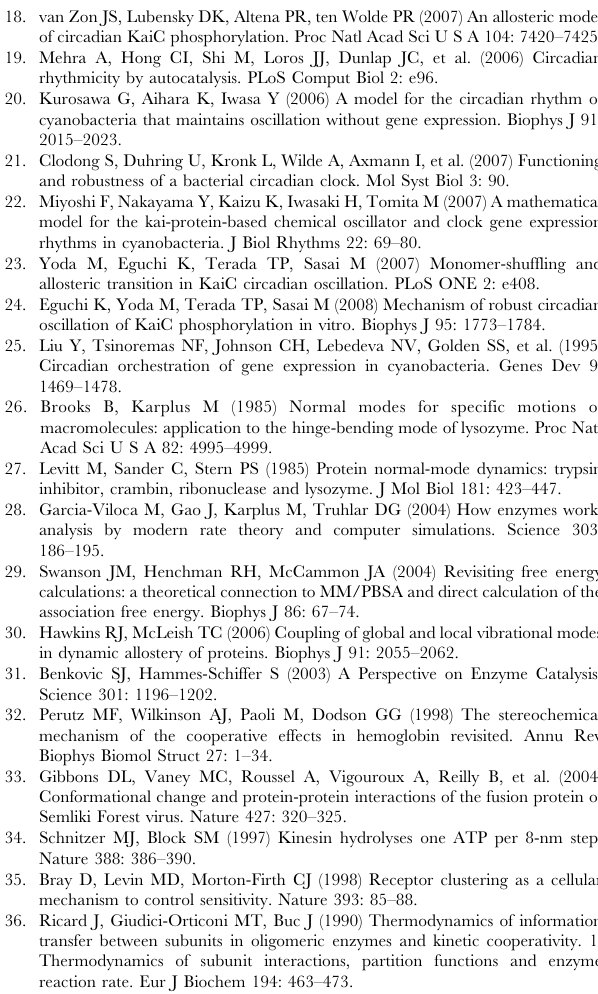
Table S1 Expressions and descriptions for reaction flows. Table S2 Relationship between ST and subunit representations. Table S3 Combinational factors of the triplets in KaiC hexamer. Table S4 Dissociation constants and rate constants in Kai reaction network.